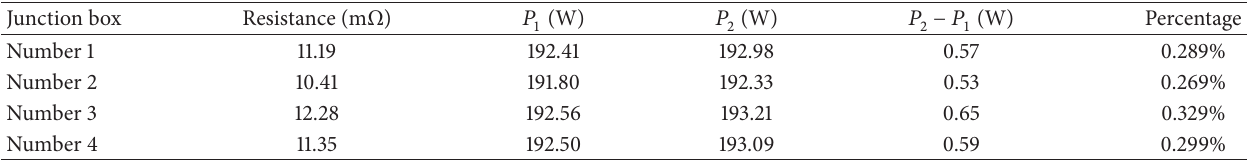
Table 6: The power loss caused by different junction box.